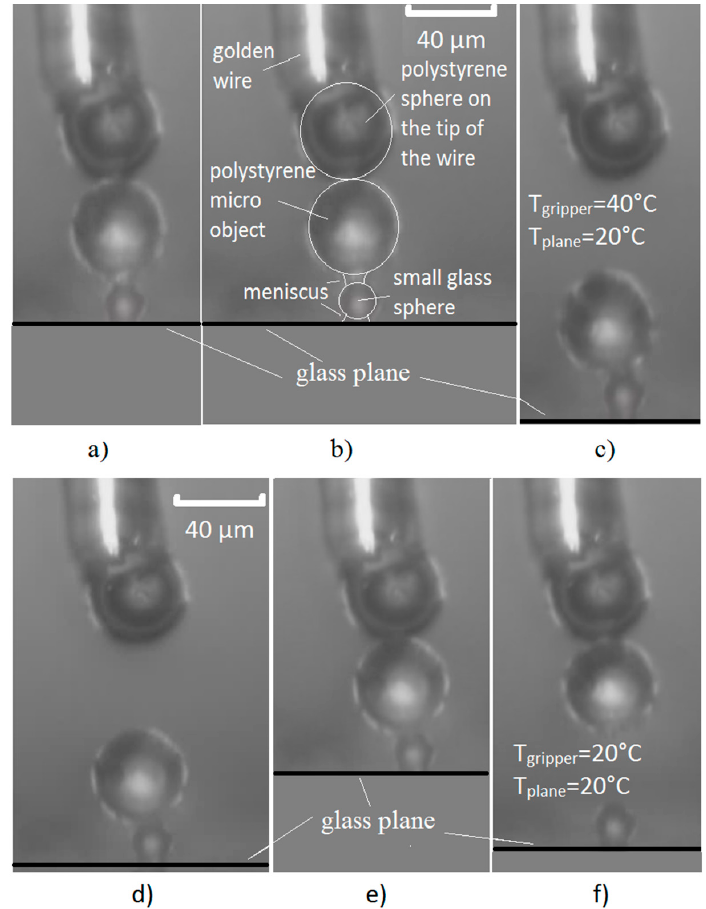
Figure 6. This figure shows the gripper gripping a polystyrene sphere with a diameter of 40 µm from a glass sphere with a diameter of 10 µm and releasing it from the gripper’s tip onto the top of a smaller glass sphere. A description of the photos is as follows: ( a ) the griper’s tip, with an attached polystyrene micro-object, is moved into contact with a smaller glass sphere; ( b ) a water meniscus is created between the plane and the smaller sphere, and between the smaller sphere and the polystyrene micro-object (larger sphere); ( c ) the gripper’s tip is moved away from the polystyrene micro-object; ( d ) a thin film of condensed water is created on the tip of the gripper and on the glass plane, forming water meniscuses between the glass plane and the smaller sphere, and between the gripper’s tip and the larger sphere—the contact between both spheres is still without a meniscus; ( e ) the polystyrene micro-object is attached to the tip of the gripper using capillary force; ( f ) the polystyrene